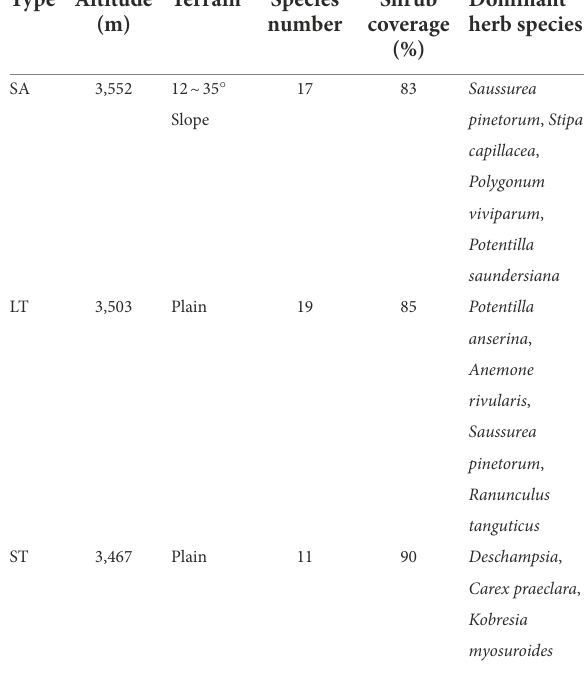
TABLE 1 General information of the study area. Type Altitude